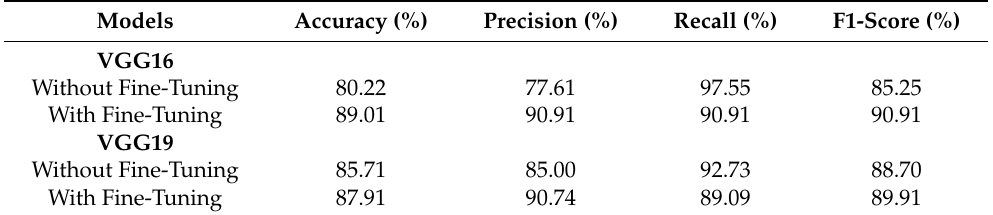
Table 13. Models with transfer learning from Dataset B (unlabeled data) for disc state classification.